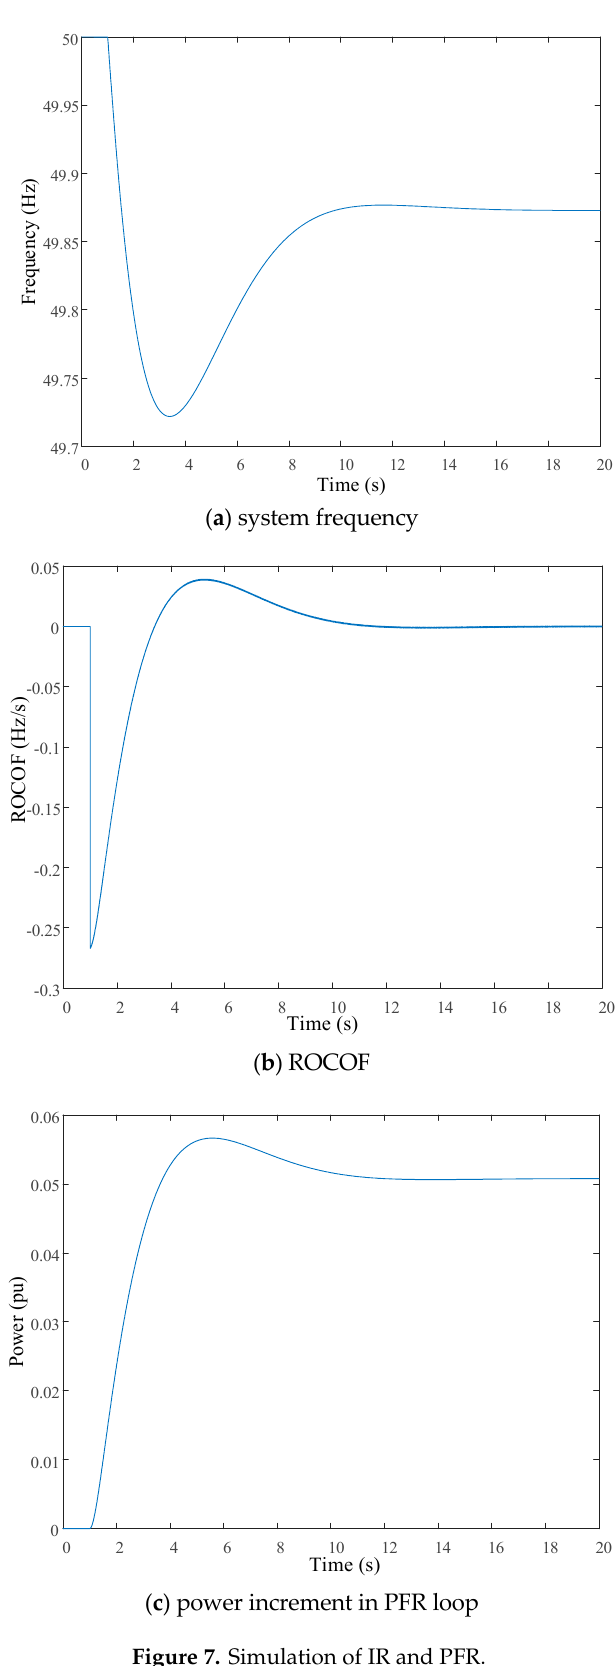
Figure 7. Simulation of IR and PFR.